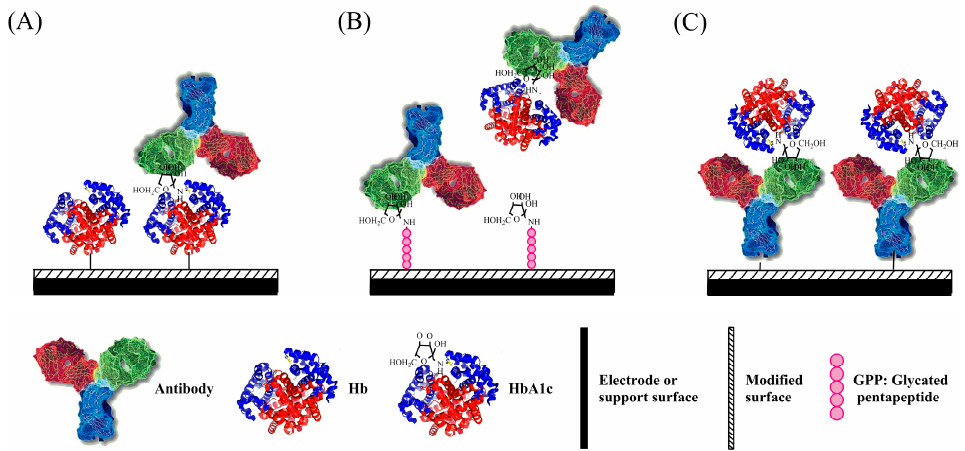
Figure 2. Schematic illustration of construction of HbA1c immunosensor by using ( A ) DOCA or Hp; ( B ) GPP; and ( C ) 3-MPA, PPy-Au NPs, and Mixed SAMs for HbA1c recognition.